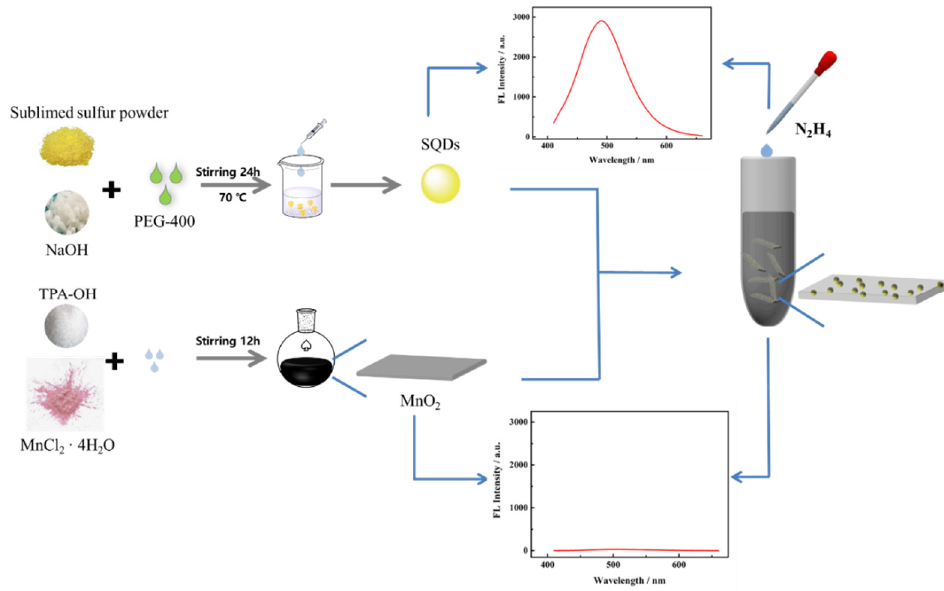
Figure 1. Mechanism of “turn-on” fluorescence sensor based on SQDs@MnO 2 NS for detecting N 2 H 4